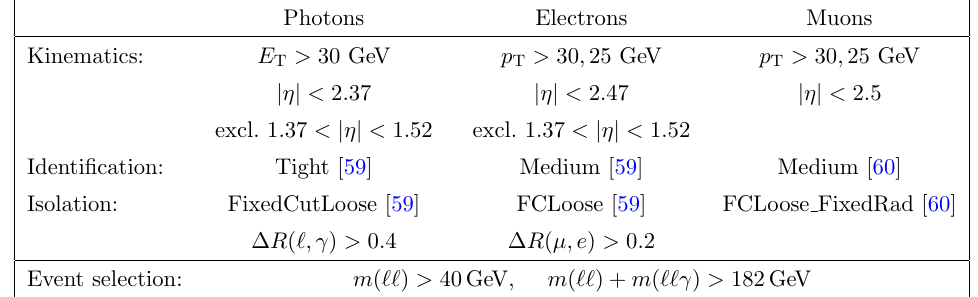
Figure 2 . Two-dimensional distribution of m ( ‘‘ ) and m ( ‘‘(cid:13) ) for events satisfying all (cid:22) + (cid:22) (cid:0) (cid:13) selection criteria except that on the sum of m ( ‘‘ ) and m ( ‘‘(cid:13) ). The diagonal dashed line shows the selection m ( ‘‘ ) + m ( ‘‘(cid:13) ) > 182 GeV used to ensure that the measurement is dominated by events in which the photon is emitted from an initial-state quark.